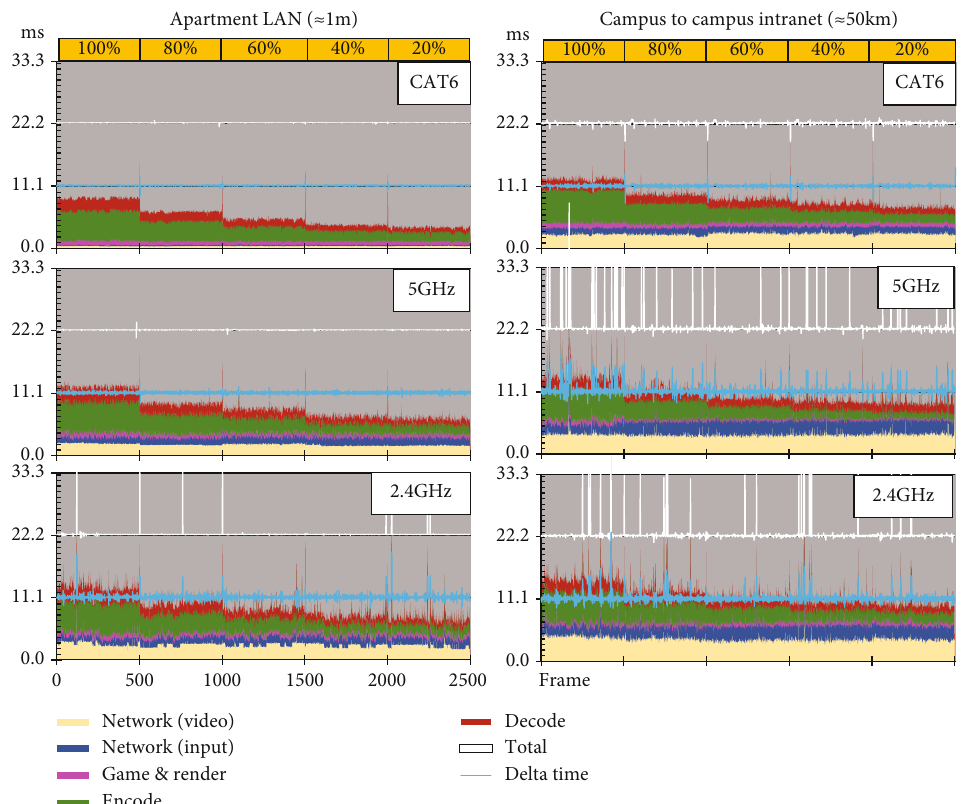
Figure 4: Examples of time consumption of the tasks performed each frame in the delay experiments. Note how total time and delta time are now separate due to a delay bu ff